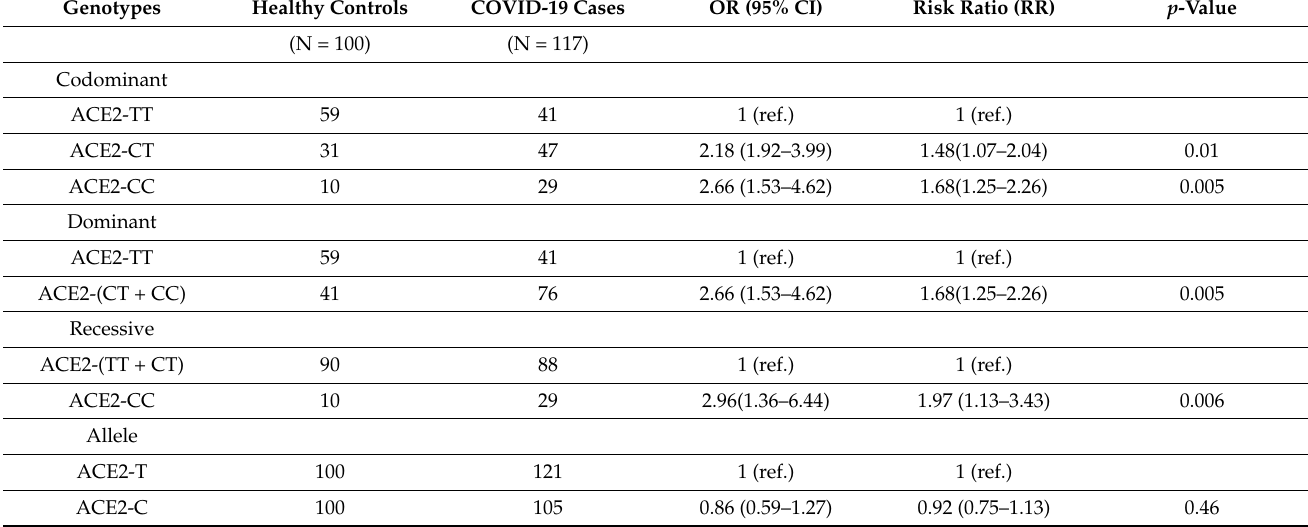
Table 9. Multivariate analysis of ACE2 rs4240157 T > C gene polymorphism with COVID-19